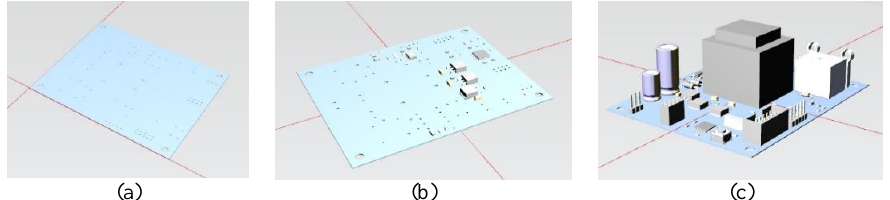
Fig. 4. The states of the moving production object recorded in the Plant Simulation database: (a) initial state – bare board; (b) one of the intermediate states – board with placed surface mount components, (c) the final state – finished